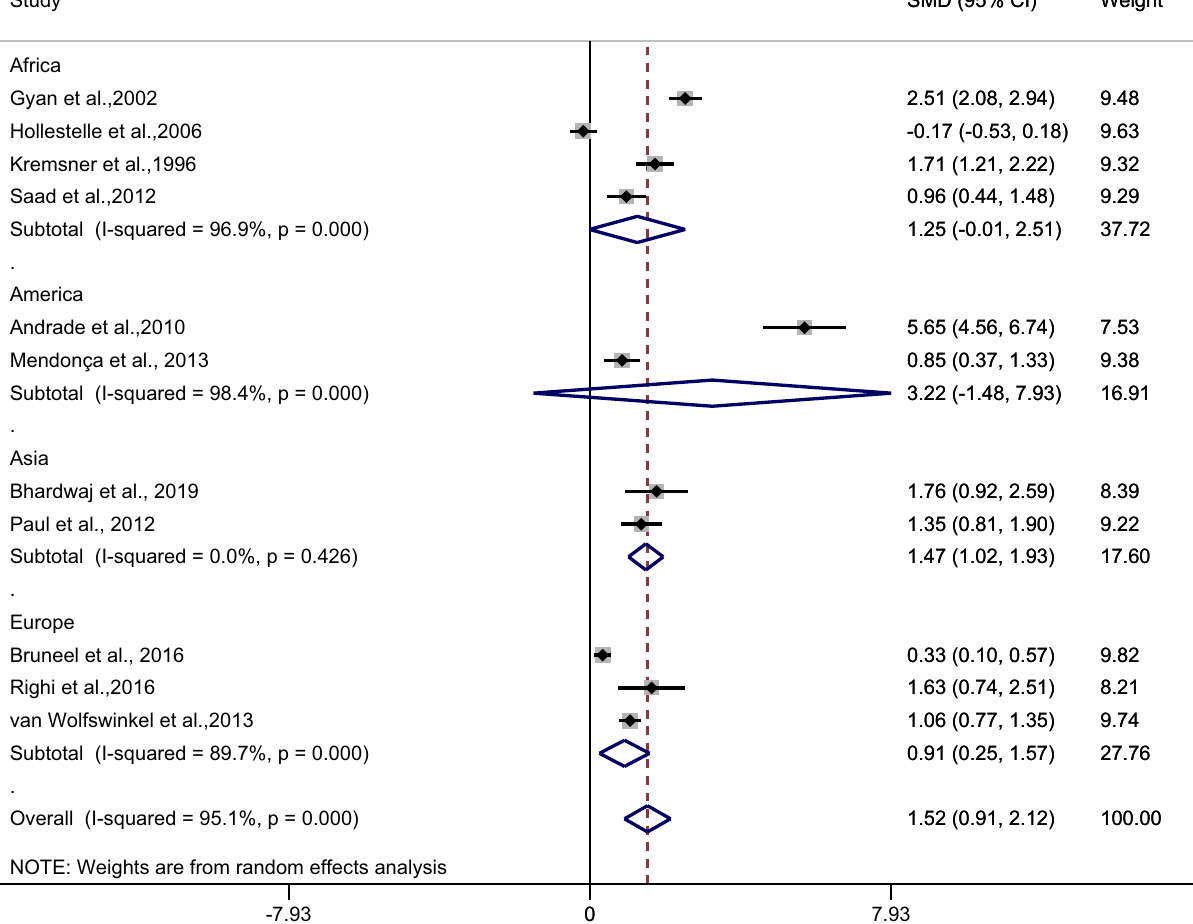
malaria compared with uncomplicated malaria patients in studies of patients with P. vivax ( p : 0.18, SMD: 3.22, 95% CI: − 1.48–7.93, I 2 : 98.4%, two studies) (Fig. 4). The difference in the mean CRP level between patients with uncomplicated and asympto - matic malaria. The difference in the mean CRP level between patients with uncomplicated and asympto- matic malaria was estimated from four studies 27,33,40,46 . The results of the individual study demonstrated a higher mean CRP level in patients with uncomplicated malaria than in those with asymptomatic malaria among the three studies 33,40,46 , while a study by Andrade et al. 27 showed no difference in the mean CRP level between the two groups. The highest difference in the mean CRP level was reported in a study by Jakobsen et al. 40 . The pooled analysis of the four studies showed a higher mean CRP level in patients with uncomplicated malaria than in those with asymptomatic malaria ( p < 0.001, SMD: 1.65, 95% CI: 0.67–2.62, I 2 : 96.7%, 4 studies) (Fig. 5). Meta-regression analysis using the mean age of participants, male percentage of participants, Plasmodium spp., or continents as covariates demonstrated no substantial impact of the mean age of participants ( p : 0.48, I 2 residual: 98.6%), male percentage of participants ( p : 0.73, I 2 residual: 96.3%), Plasmodium spp. ( p : 0.59, I 2 residual: 96.91%), or continents ( p : 0.49, I 2 residual: 96.07%) on the heterogeneity. The difference in the mean CRP level between patients with uncomplicated malaria and febrile/ healthy controls. The difference in the mean CRP level between patients with uncomplicated malaria and febrile/healthy controls was estimated from 12 studies 26,27,30,36,37,39,40,44–46,50,54 . A meta-analysis of the difference in mean CRP level between patients with uncomplicated malaria and febrile/healthy controls were divided into three subgroups: uncomplicated malaria and febrile controls, uncomplicated malaria and healthy controls, and uncomplicated malaria and febrile/healthy controls because previous studies 27,46 reported the mean/median CRP levels of febrile and healthy controls.